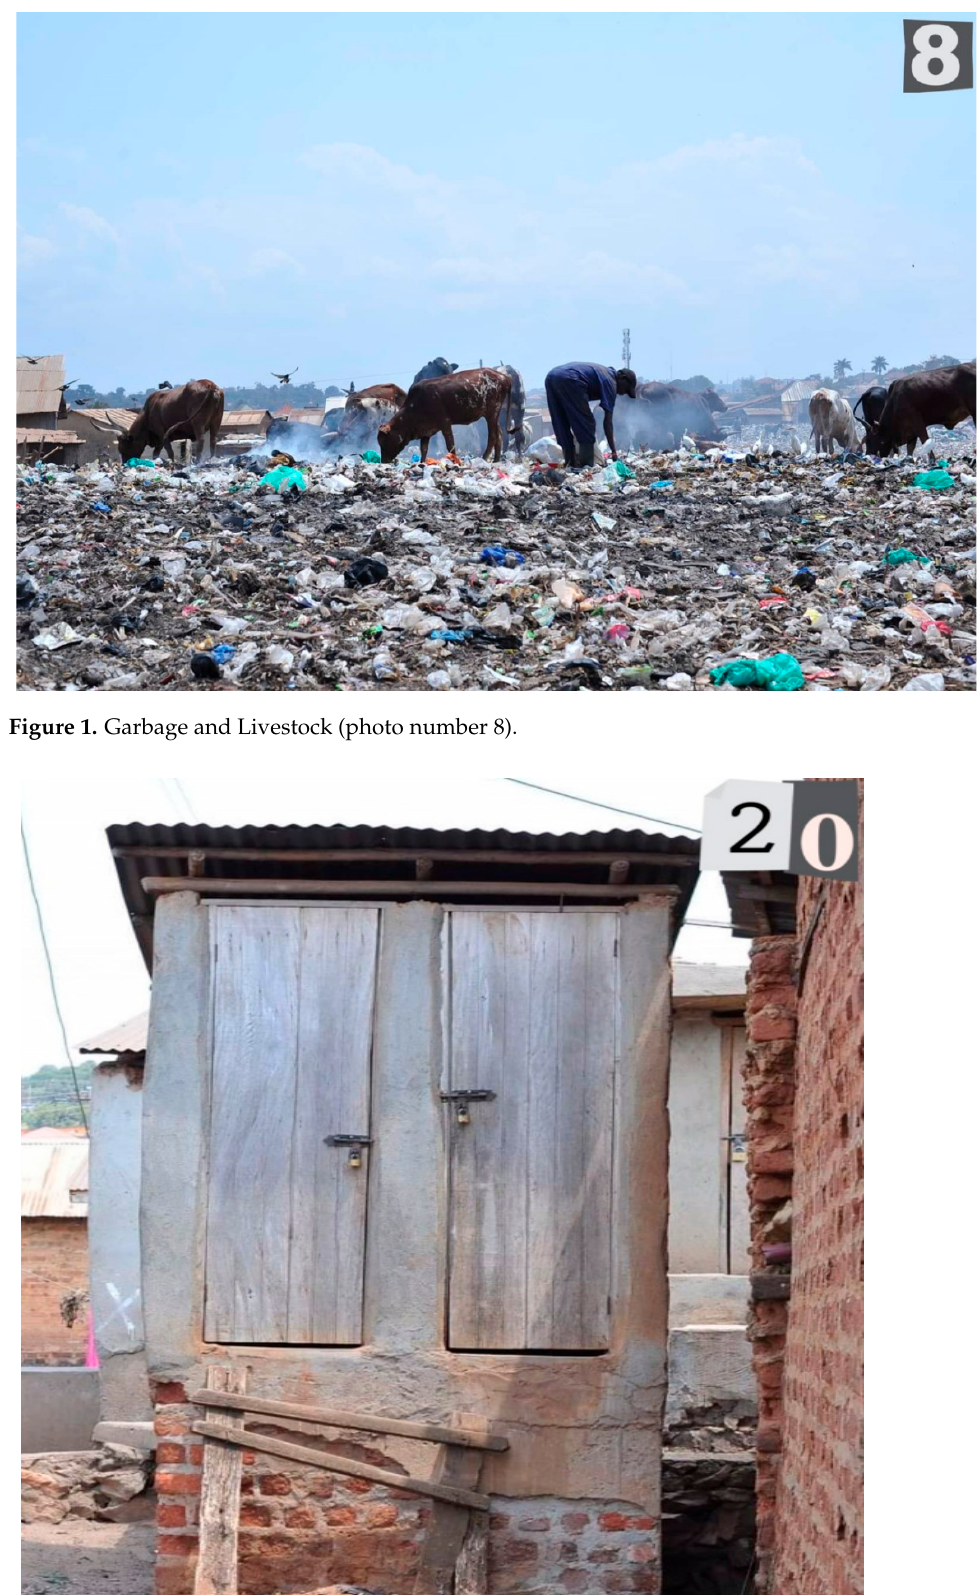
Figure 3. Children Walking over Bridge (photo number 25). Four photos reflected multiple emotional responses of happy and sad, and depicted the weekly market, women entrepreneurs cooking, women fetching water in a well (Fig- ure 4), and a movie hall for entertainment.